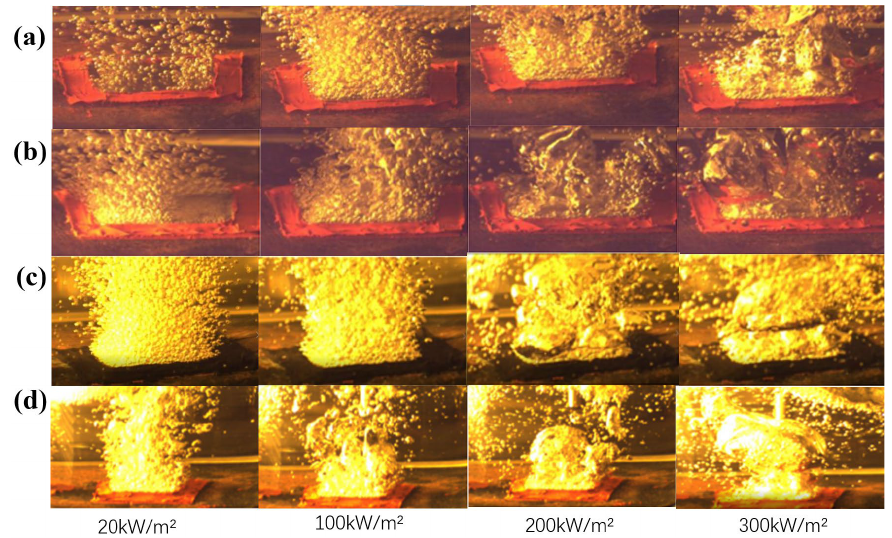
Figure 11. Boiling bubbles on sintered porous wick: ( a ) aluminum plate, ( b ) D6P5-05, ( c ) D6P4-05, ( d ) D13P4-05.